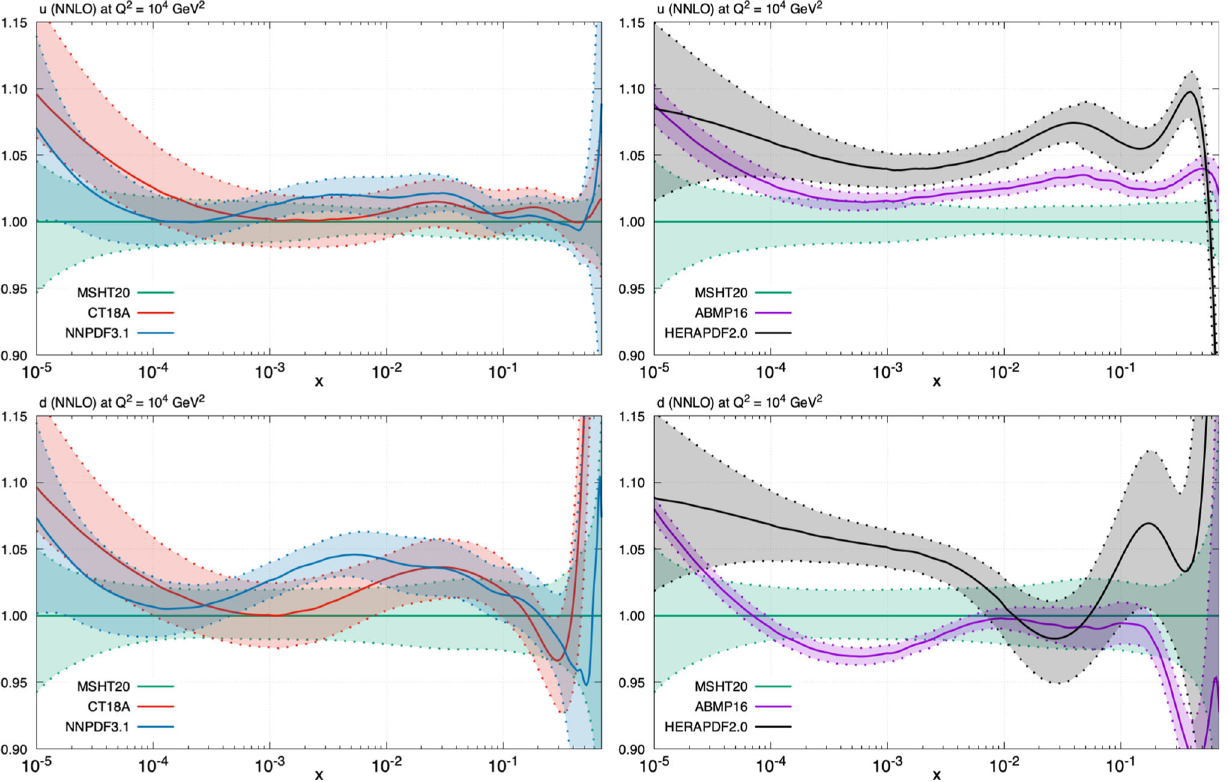
Fig. 91 Comparison of the MSHT20 NNLO up and down quark PDFs at Q 2 = 10 4 GeV 2 with other representative PDF sets, presented as a ratio ) = 0 . 118 in all cases to the MSHT set. These correspond to α S ( M 2 Z DIS data. The uncertainty for the gluon and all other PDF sets shown is smaller than ours, due to the use of a simple (cid:5)χ 2 = 1 criterion for the calculation of PDF